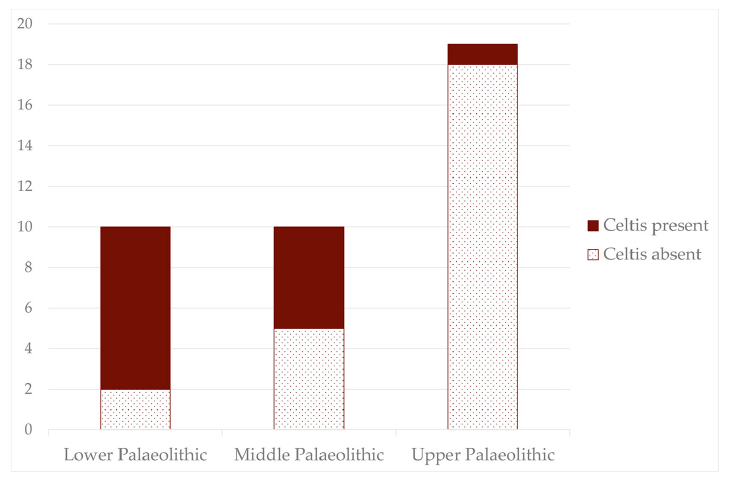
Figure 10. Celtis presence on the total of Palaeolithic sites with carpological analyses.